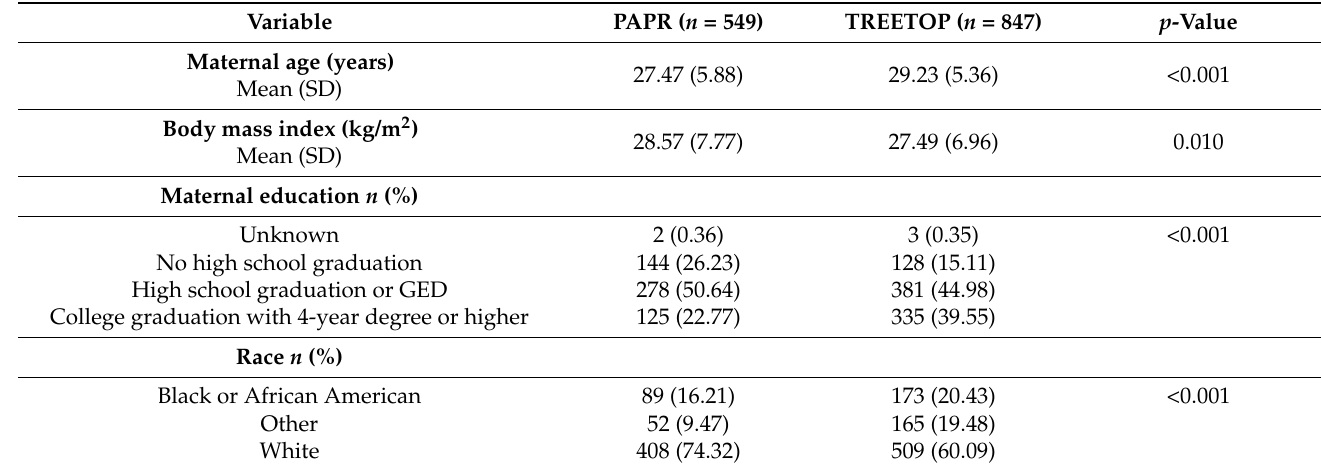
Table 1. A comparison of the PAPR and TREETOP